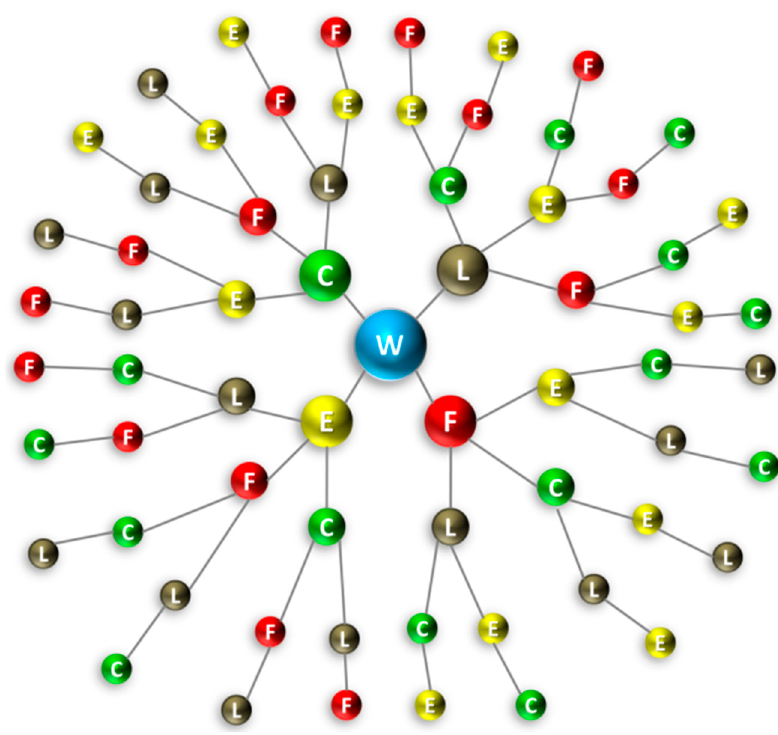
Figure 2. A nexus tree for Water showing the formation of all 24 unique fourth-order interlinkages. Similar trees can be created for all five nexus dimensions (W = Water, E = Energy, F = Food, L = Land Use, C = Climate), creating a total of 120 unique fourth-order interlinkages for the five-dimensional nexus. Color representation for nexus tree nodes are as follows: Water = blue; Energy = yellow; Food = red; Land = brown; Climate = green.